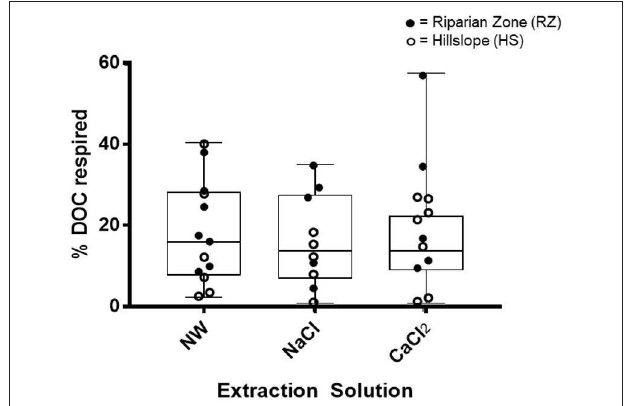
FIGURE 12 | The distribution for the bioavailability of carbon by extraction solution (NW, Nanopure Water; NaCl, sodium chloride; and CaCl 2 , calcium chloride) and representative landscape position reported as % DOC respired (loss). None of the treatments or representative landscape positions were significantly different.